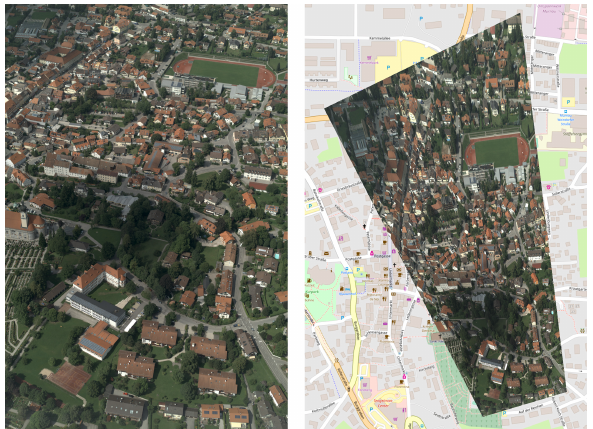
Figure 4. Projective mapping: aerial image and its perspective projection by application of corresponding transformation matrix